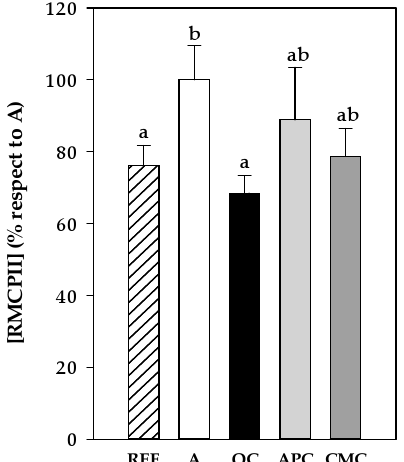
Figure 6. Rat mast cell protease II (RMCPII) in plasma obtained 1 h after the intranasal challenge. REF: healthy animals fed standard diet; A: asthmatic animals fed standard diet; OC: asthmatic animals fed with ordinary cocoa-enriched diet; APC: asthmatic animals fed with “Amazonas Peru” cocoa-enriched diet; CMC: asthmatic animals fed with “Criollo de Montaña” cocoa-enriched diet. Results are shown as mean ± standard error ( N = 9). Results are expressed as mean ± standard error ( N = 9) of absorbance units. Values not sharing letters denote significant differences between groups ( p < 0.01), while values sharing the same letter did not differ.